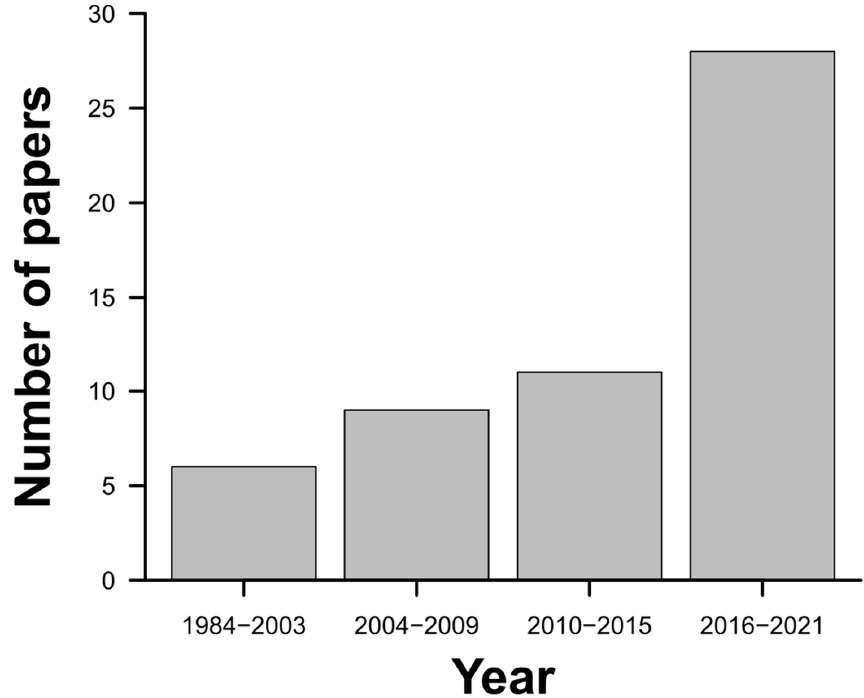
Figure 2. Distribution of the 54 papers evaluated in the present study over the time (years). Table 1. Number and % of papers produced with information generated in field, laboratory, and both. “Description” reflects the description of the sampling site described by authors in the articles.